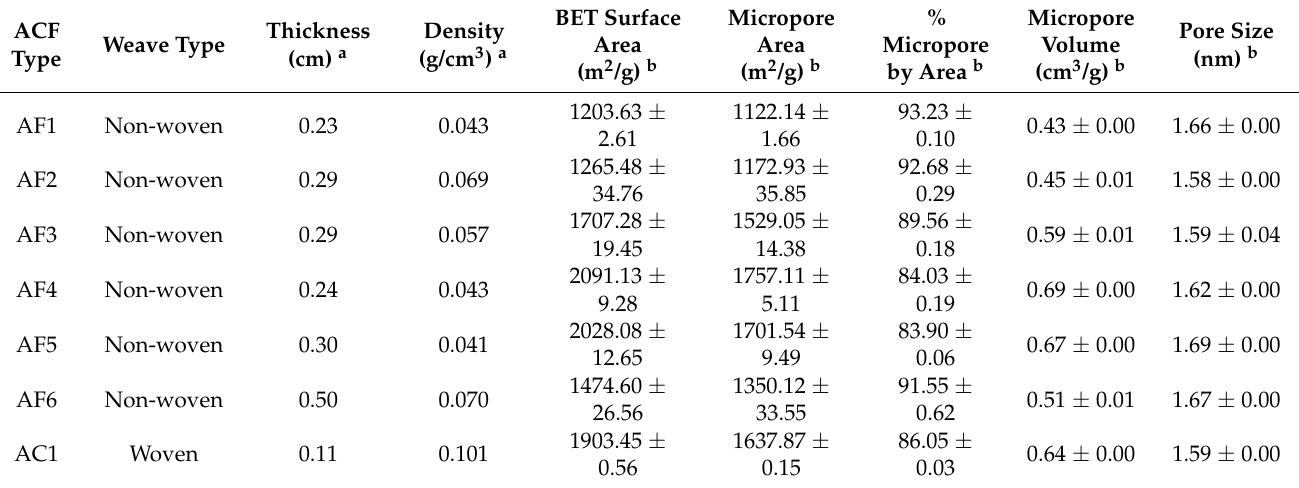
Table 2. Activated carbon fiber (ACF) structural properties by ACF